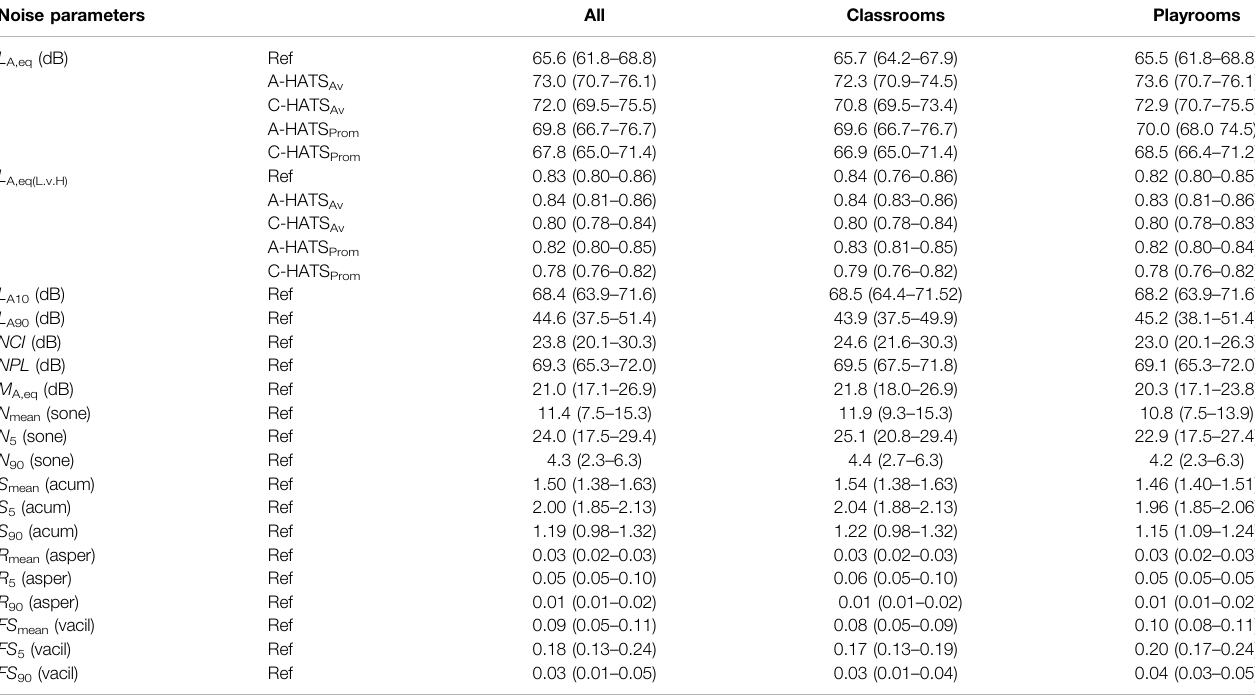
TABLE 7 | Summary of noise parameters. Reported values are mean and the range (in brackets). Noise parameters